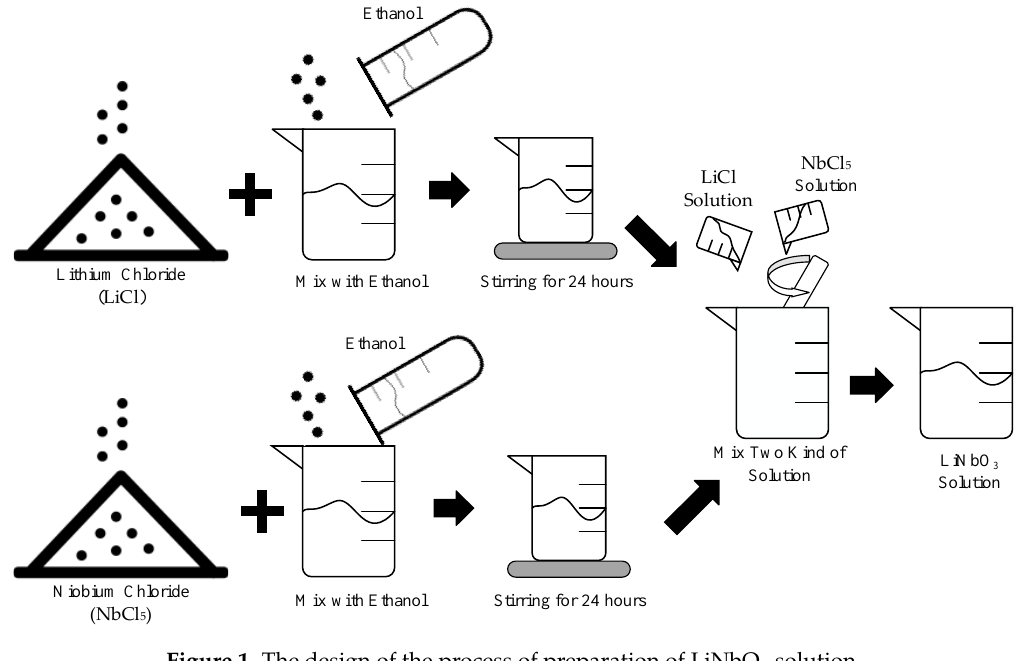
Figure 1. The design of the process of preparation of LiNbO 3 solution.